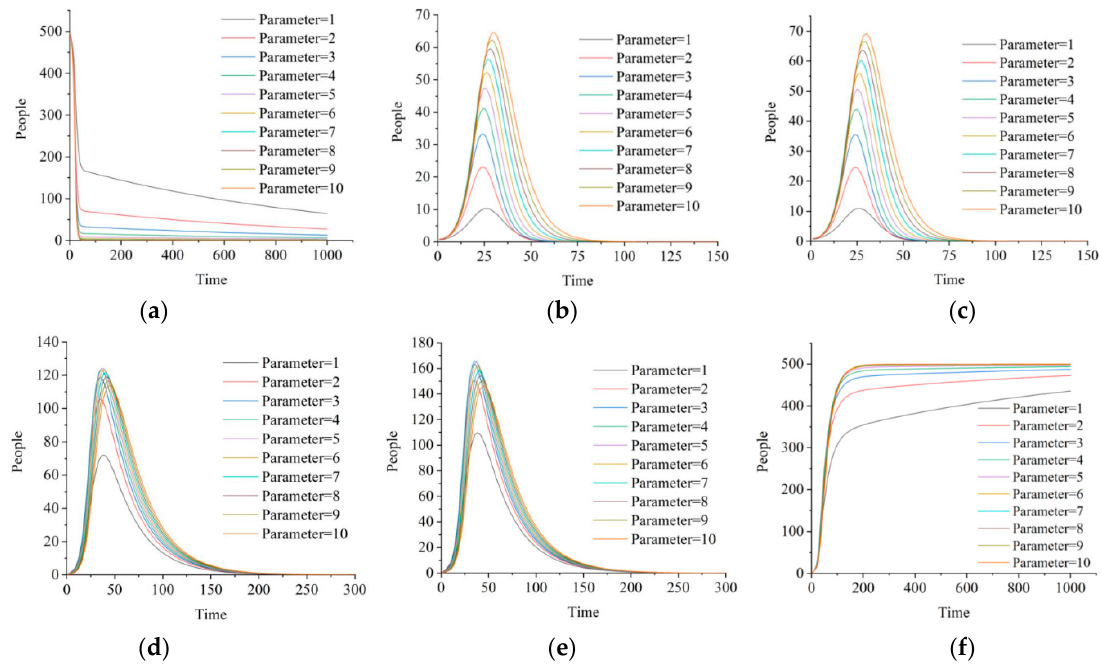
Figure 7. Sensitivity simulation for decision-making capability. ( a – f ) show the evolution of the number of 1 to 10 values for each component of decision-making ability for the risk, active strategy, passive strategy, competitive strategy, cooperative strategy and safety populations,